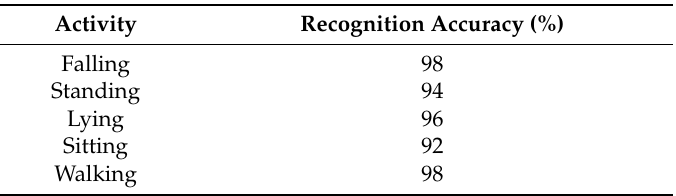
Table 3. Activity recognition